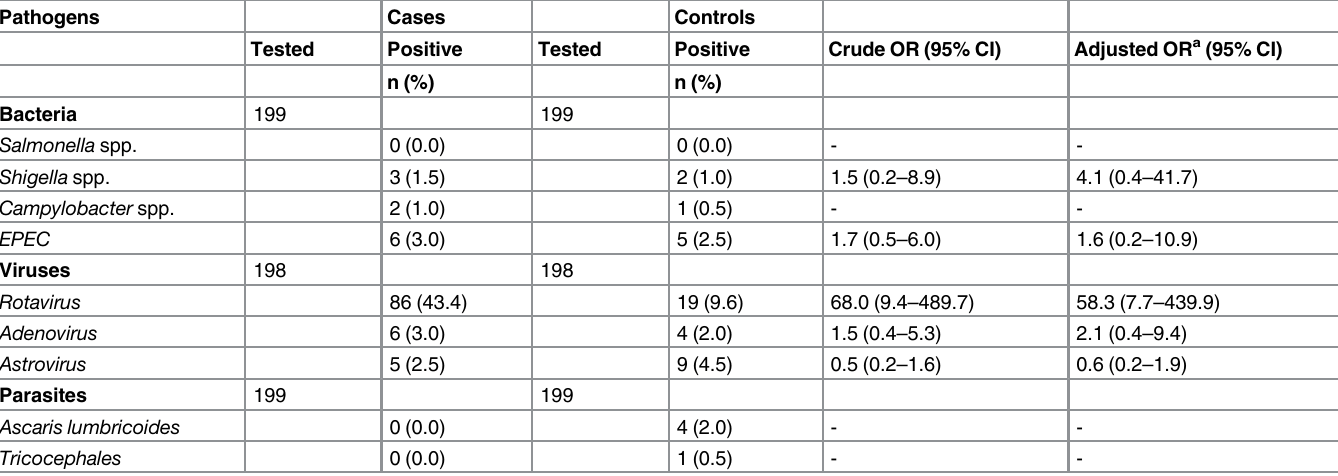
Table 3. Case-control results for the pathogens isolated in Antananarivo and Moramanga, 2011 – 2014. Pathogens